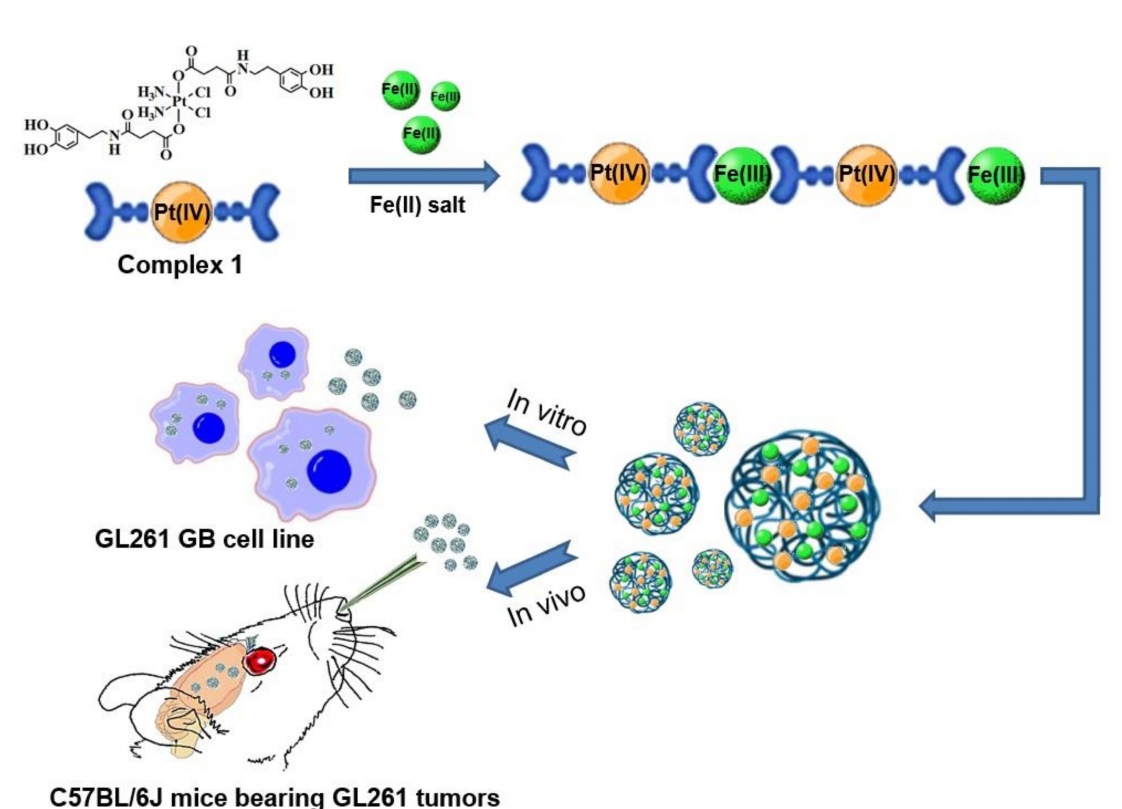
Figure 1. Scheme of the Pt-Fe NCPs synthesis upon polymerization of complex 1 with iron ions as metal nodes in open to air conditions, and analysis of their therapeutic effect in vitro (GL261 cell line) and in vivo murine models (C57BL/6J mice bearing orthotopic GL261 GB